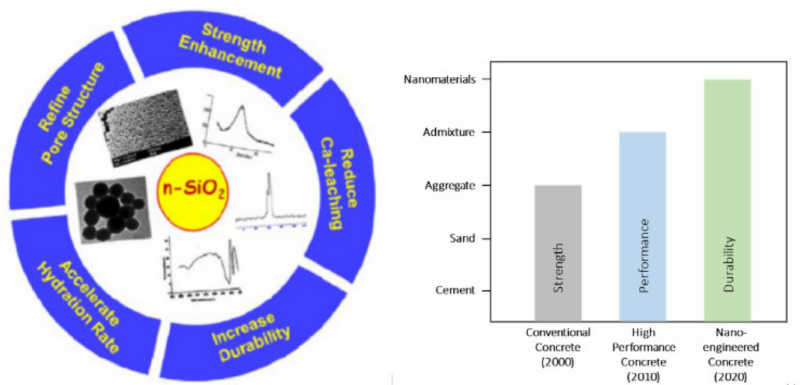
Figure 9. How nanosilica behaves within the cement matrix [19] and improved properties (source: own elaboration).